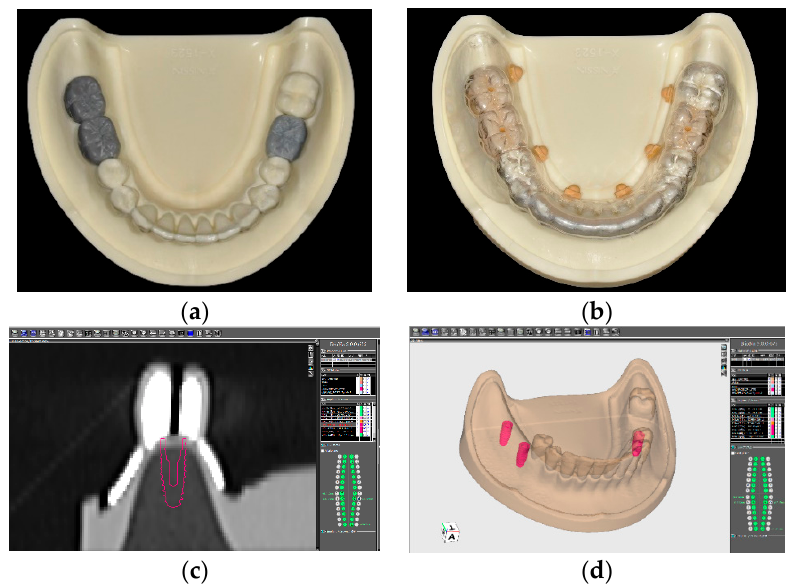
Figure 2. Preparation and planning of the surgical guide. ( a ) Wax-up of the missing teeth. ( b ) Radiographic scan template converted from the wax-up. ( c ) Based on the wax-up, an implant with proper length and diameter was selected. ( d ) Three implants were virtually planned at the missing molar positions.